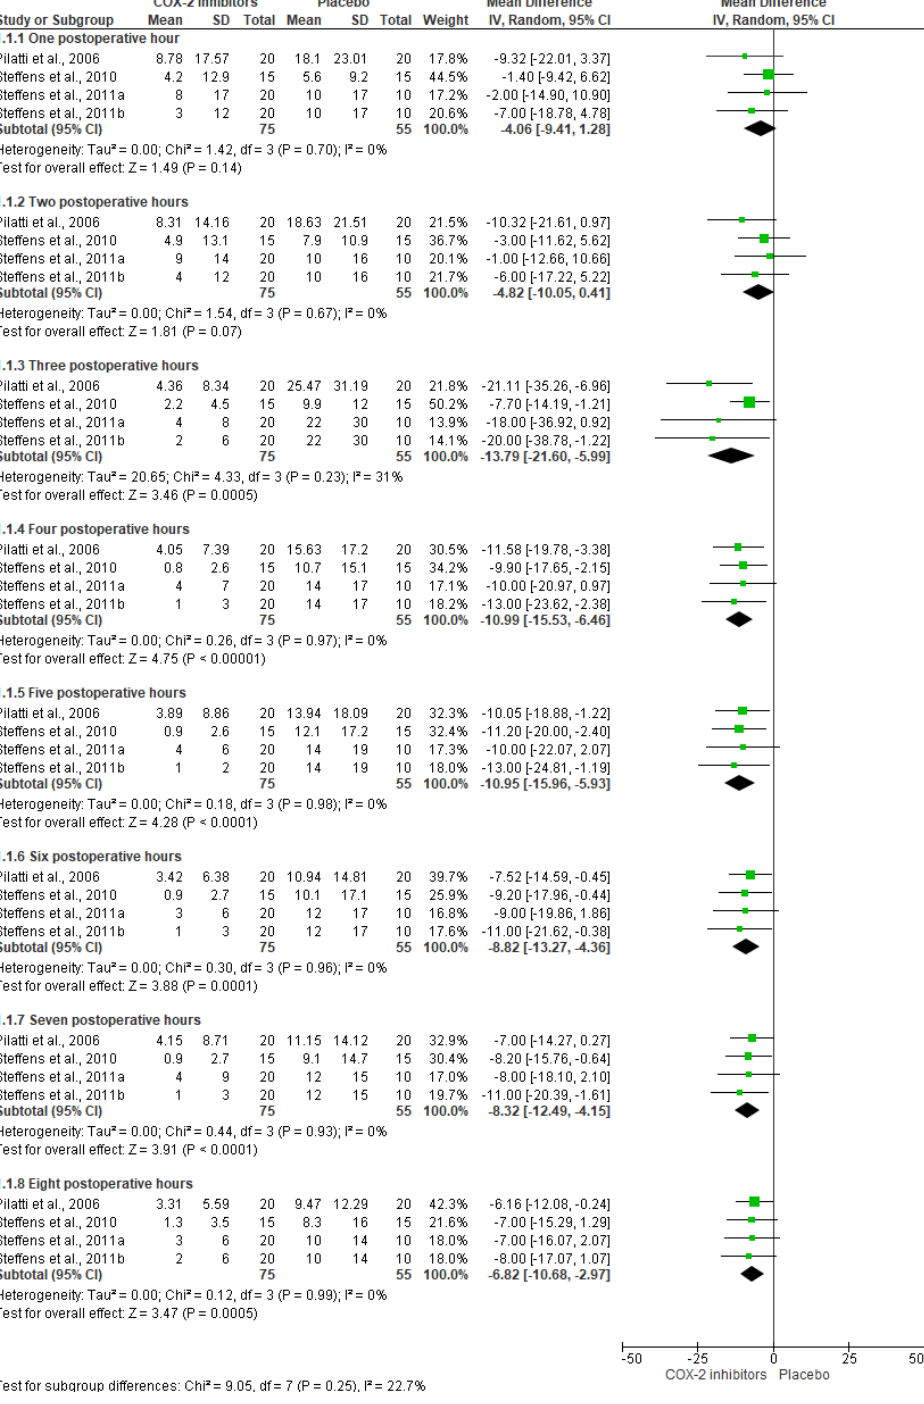
Figure 4. Postoperative pain intensity using COX-2 agents versus placebo in periodontal surgery ( p < 0.05) [26–28].